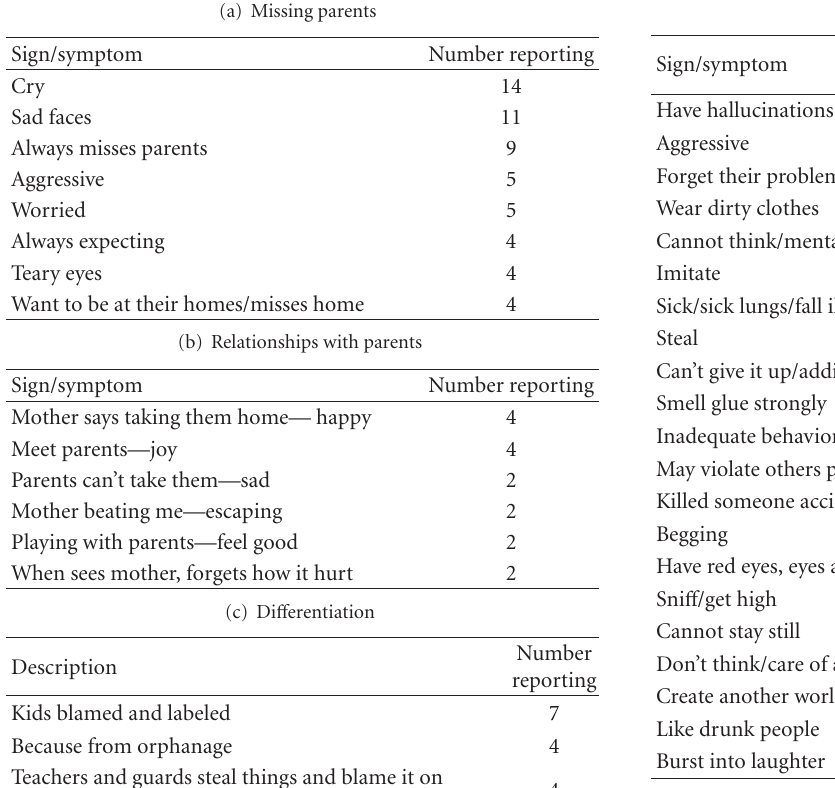
Table 7: Key informant responses, orphanages ( N = 21). Table 8: Key informant responses, centers ( N =